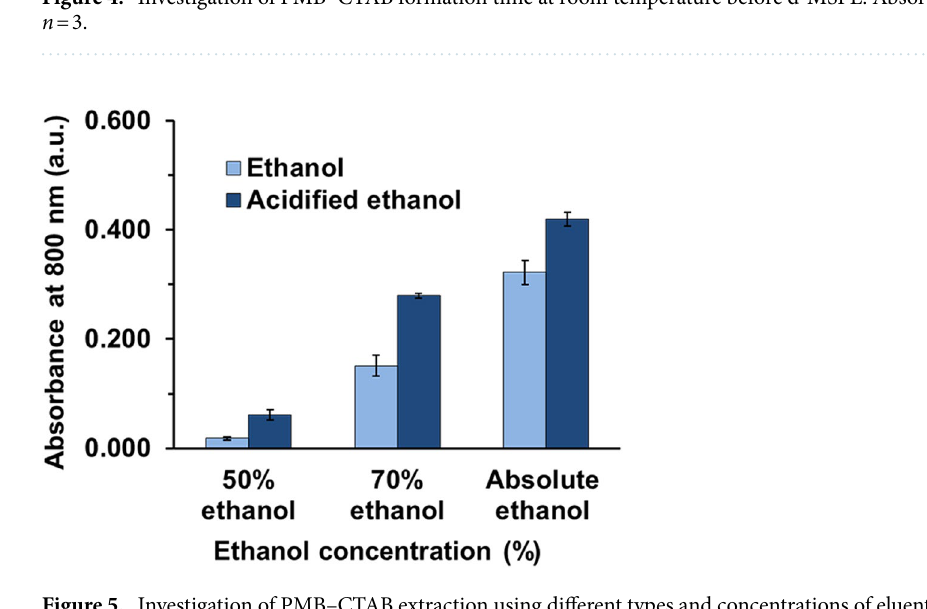
Figure 5. Investigation of PMB–CTAB extraction using different types and concentrations of eluent. Absorbance ± SD, n =